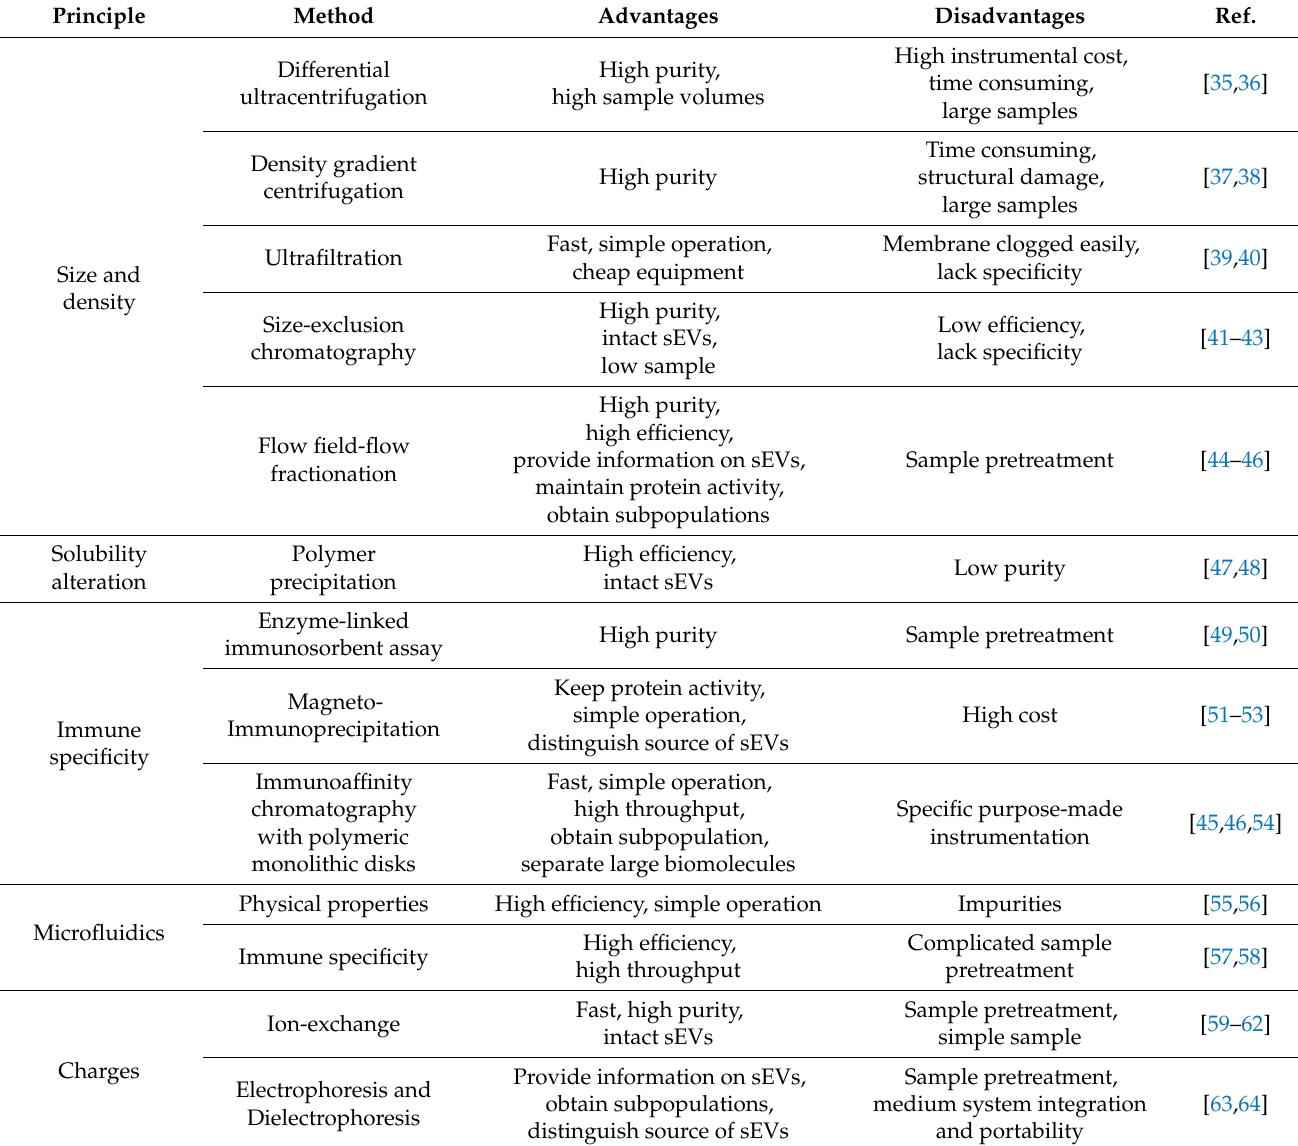
Table 1. Techniques for sEV